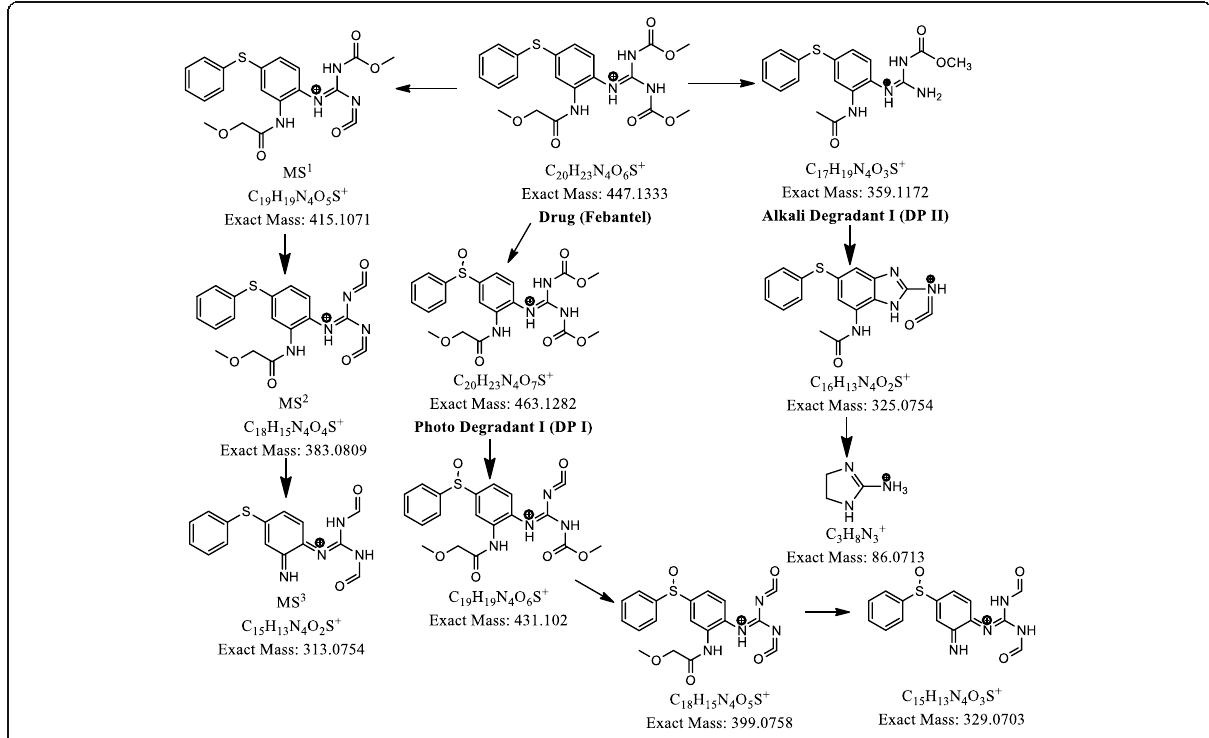
Scheme 1 Proposed mass fragmentation pathway of the drug and two degradation products